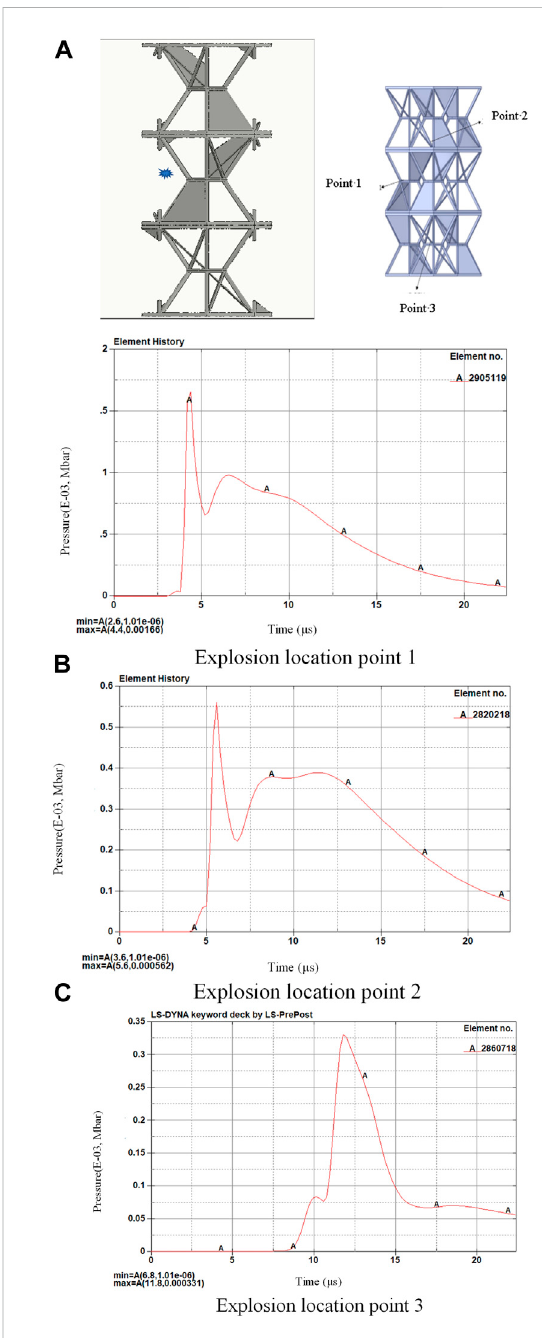
FIGURE 9 X-direction velocity of the measuring point in front of